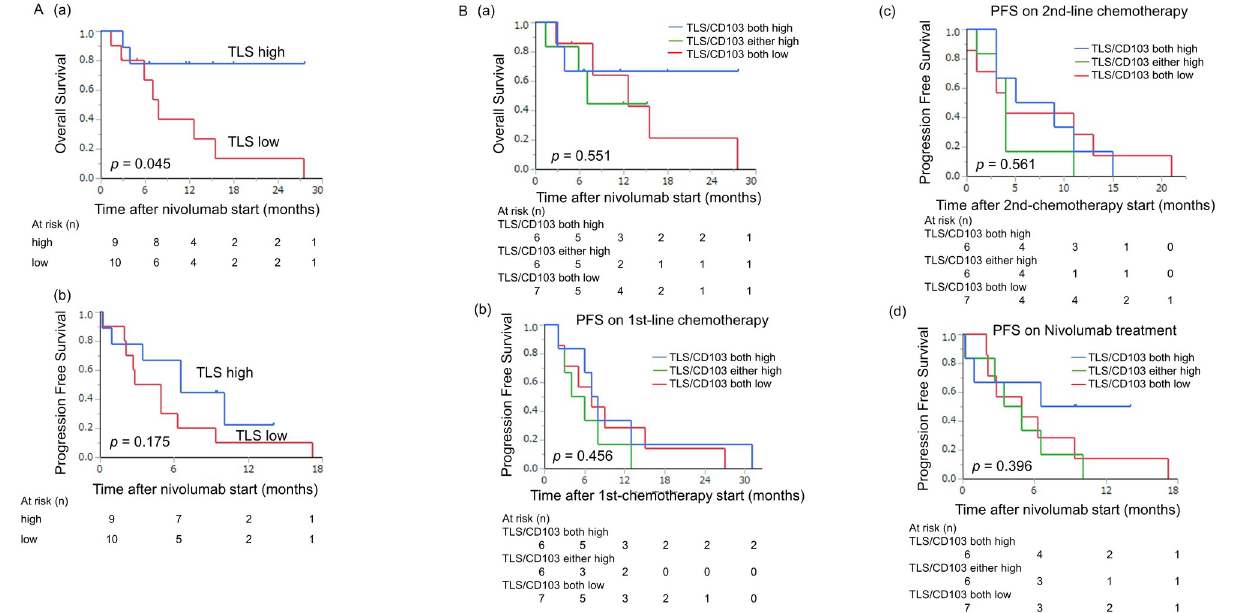
Fig 2. Prognostic impact of TLS in GC. (A) Kaplan-Meier plots using the log-rank test for OS and PFS according to the percent area of TLS. Patients with TLS high had a better prognosis than those with TLS low (a: OS; p = 0.045). Patients with TLS high tended to have a better prognosis (b: PFS; p = 0.1752). (B) Kaplan-Meier plots using the log-rank test for OS according to the combination of TLS and CD103 + T cells. (a) Patients with TLS high and CD103 high tended to have a better prognosis than other groups. (b-d) There was not a statistically significant difference in PFS on 1st- and 2nd- line chemotherapy and nivolumab therapy. When nivolumab therapy was used as the starting time of PFS, individuals with high TLS and high CD103 tended to have longer PFS.